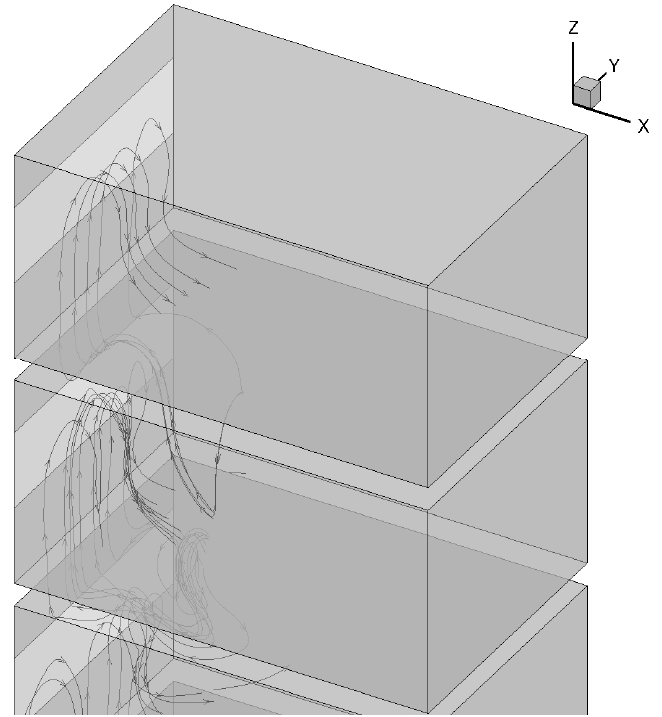
Figure 4. Cascading effect in the single-side ventilated building upstream (canyon